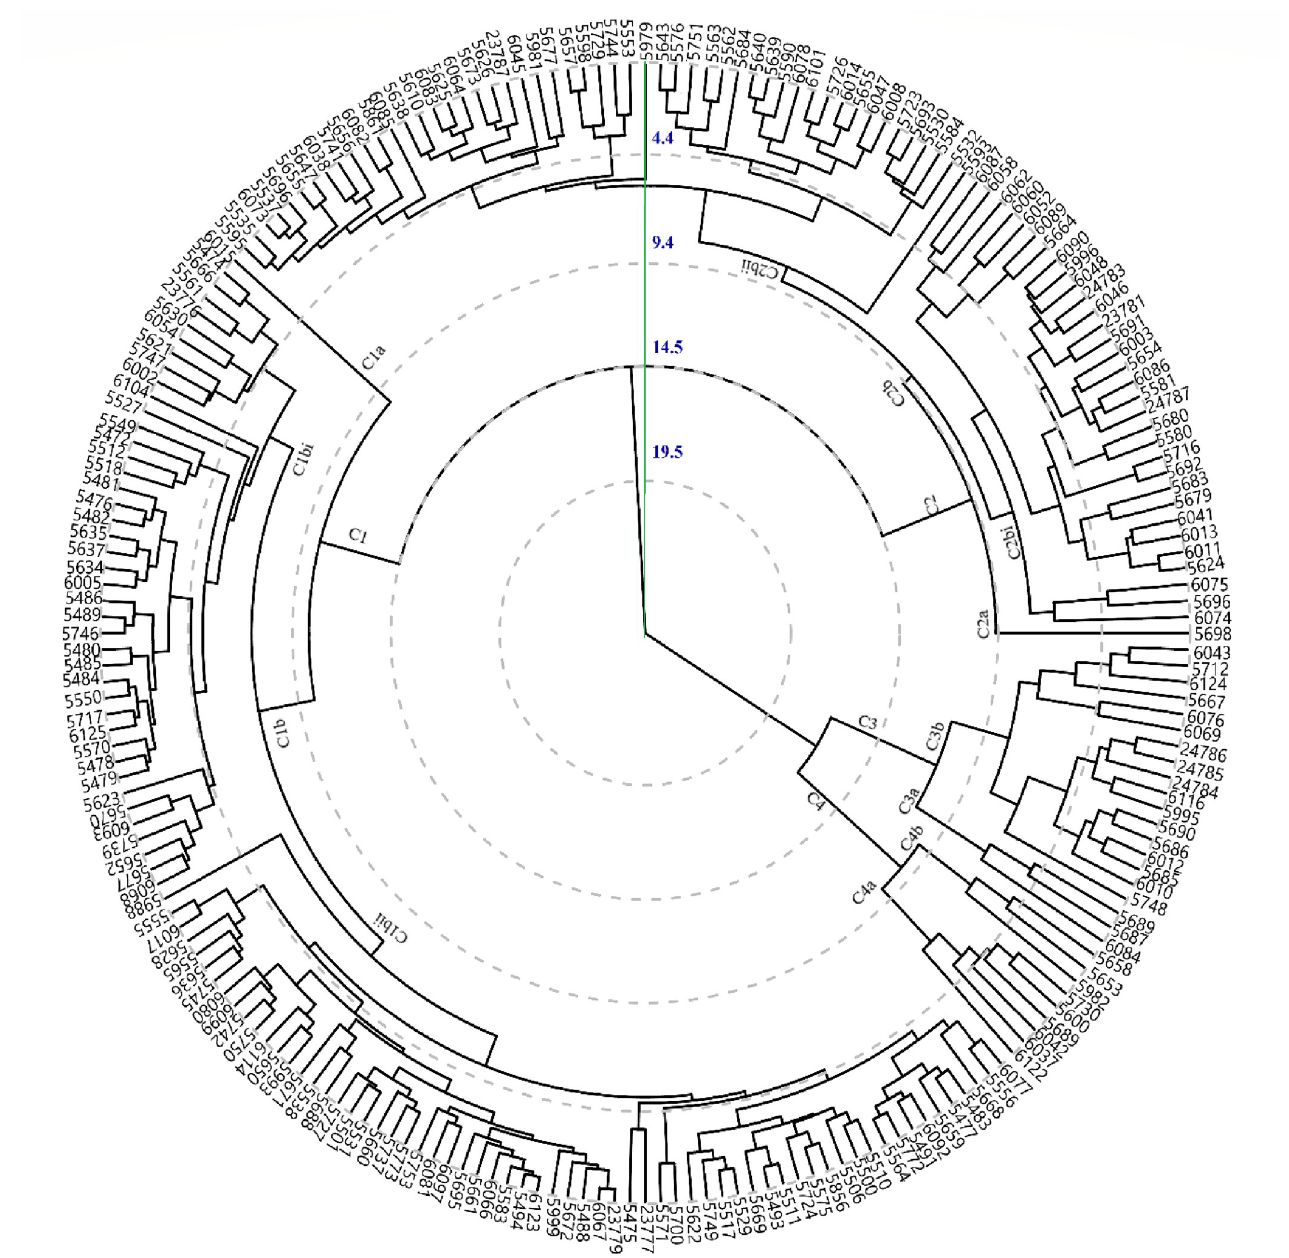
Fig 5. Hierarchical dendrogram showing the relationship of lentil genotypes for quantitative traits studied during 2017–18. (Table 5). These results were in coordination when verified by the lowest error variance of multiple linear regressions. Coefficient of determination (R 2 = 0.64) for multiple linear rela-